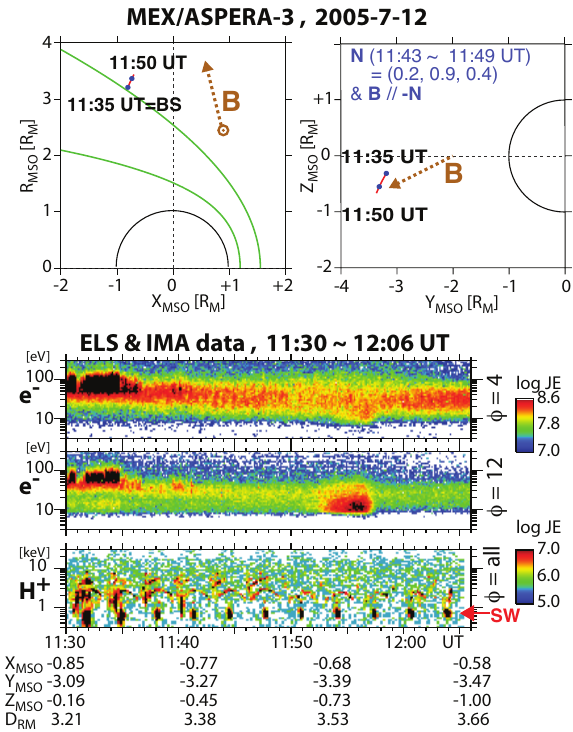
Fig. 6. Overview of the MEX orbit during 11:35 ∼ 11:50UT and hot plasma data during 11:30 ∼ 12:06UT on 12 July 2005. The format is the same as in Fig. 3 except that there is no magnetic field measure- q + Z 2 Y 2 is used instead ment and that cylindrical R MSO = MSO MSO of Y MSO in the top left panel. There, the average boundary posi- tions (bow shock and induced magnetosphere boundary) are drawn with green lines. The unit R M is the Mars radius (3397km). The solar wind protons are seen at around 0.7keV in the proton panel (regularly repeating every 192s). The bow shock is recognized at around 11:35UT, and multiple ring-like structures are recognized until around 11:50UT. The projection of the magnetic field direc- tion derived from the ring-like structure is drawn on the orbit plots in the top panels (see